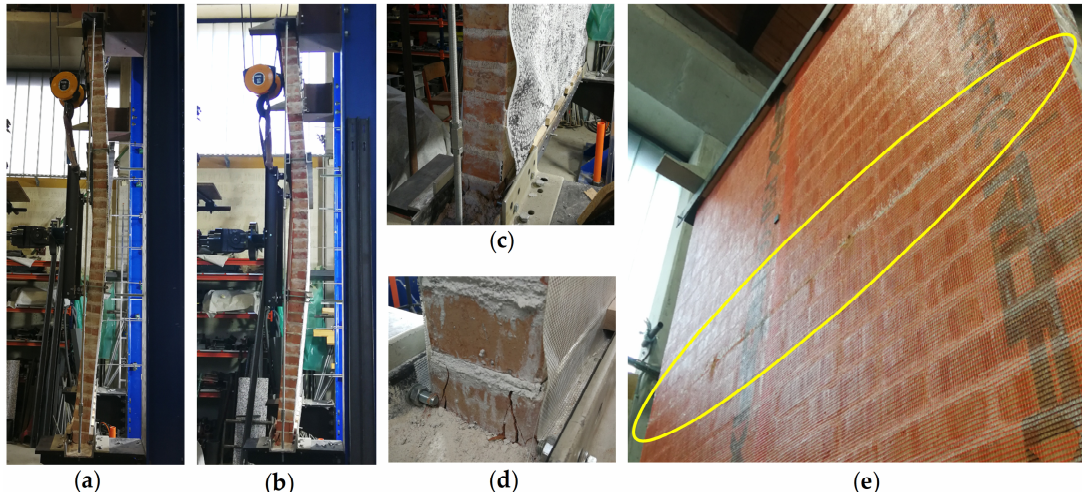
Figure 6. Deformation shapes of full surface strengthened specimens ( a ) NF-A and ( b ) NF-B; characteristic failure modes: ( c ) debonding of RF in NF-2A, ( d ) compressive failure of bricks in NF-1A, and ( e ) tension failure of RM in